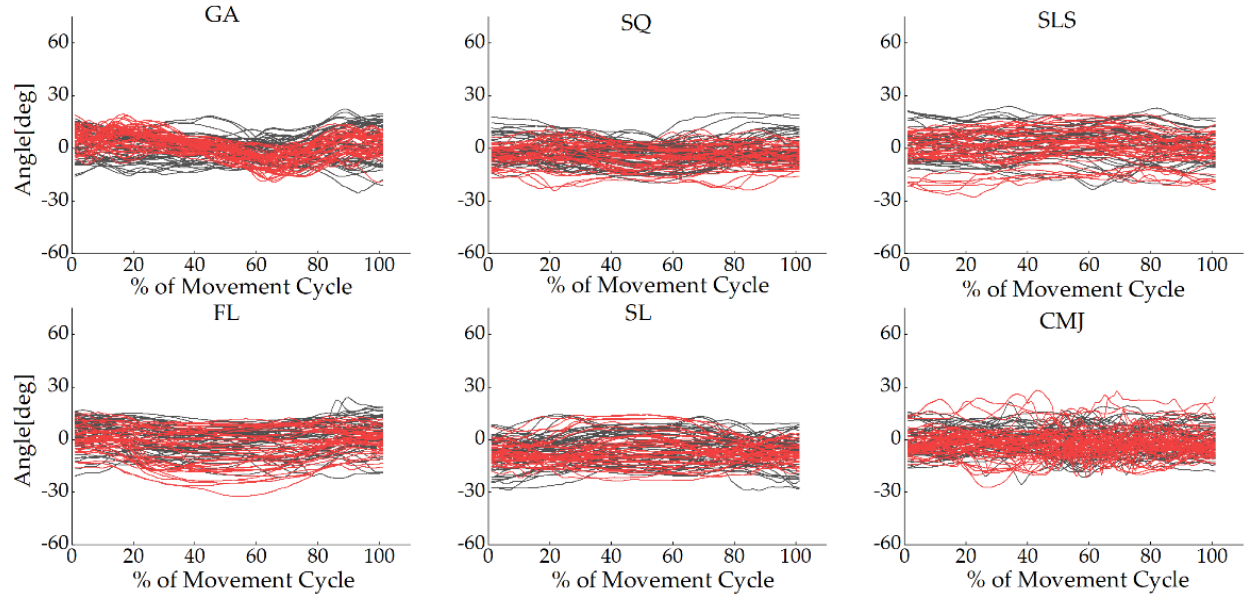
Figure A2. Hip joint angles in the transverse plane for each participant in all tasks during the movement cycle of the gait (GA), squat (SQ), single-leg squat (SLS), side lunge (SL), forward lunge (FL), and counter-movement jump (CMJ). The black lines represent the OptiTrack system, while the red lines represent the Perception Neuron ® system. The Y -axis depicts joint angles in degrees, while the X -axis depicts the movement cycle in %.